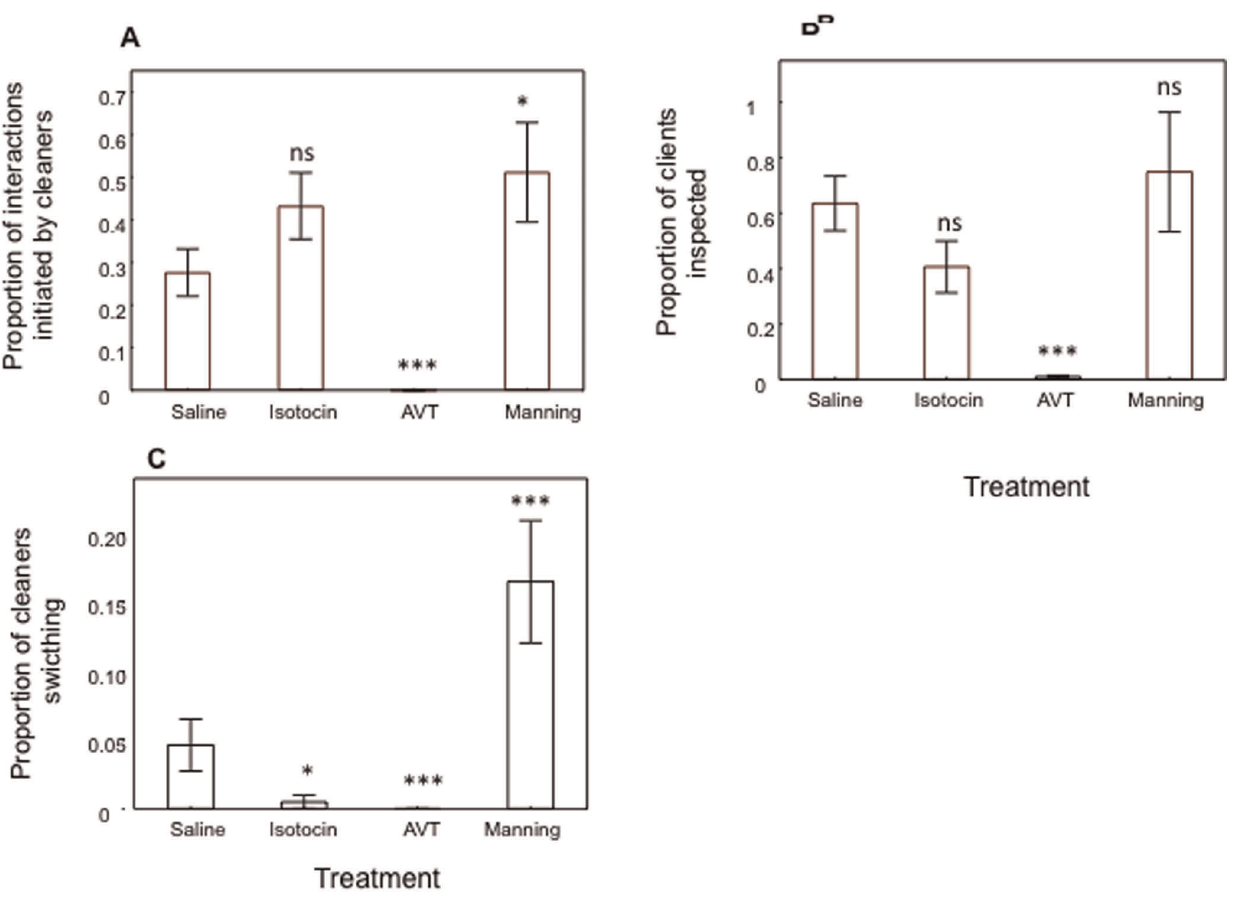
Figure 1. The effect of the neuropeptides isotocin, arginine vasotocin (AVT), and manning compound (Manning) on the cleaning behaviour of the cleaner fish Labroides dimidiatus , measured in the field and compared with a control (saline), for several behaviours. A) proportion of interactions initiated by cleaners (number of cleaning events initiated by cleaners/total number of cleaning events, B) proportion of clients that were inspected (number of clients’ cleaned/total number of visits) and C) proportion of cleaners switching from a current client to a newly arrived client (number of times cleaner switched between clients/total number of cleaning events). Measures A and C were arcsine- square root transformed to achieve normality but are presented untransformed here to facilitate visual comparisons between variables. Means are shown 6 1 SEM. Symbols above bars represent P values which refer to planned comparisons of least squares means effect of each neuropeptide treatment group against the reference (saline) group (*, , 0.05; ***, , 0.001; ns, . 0.05). The sample size for saline, isotocin and AVT was n=8 per group, and for manning compound it was n=6.